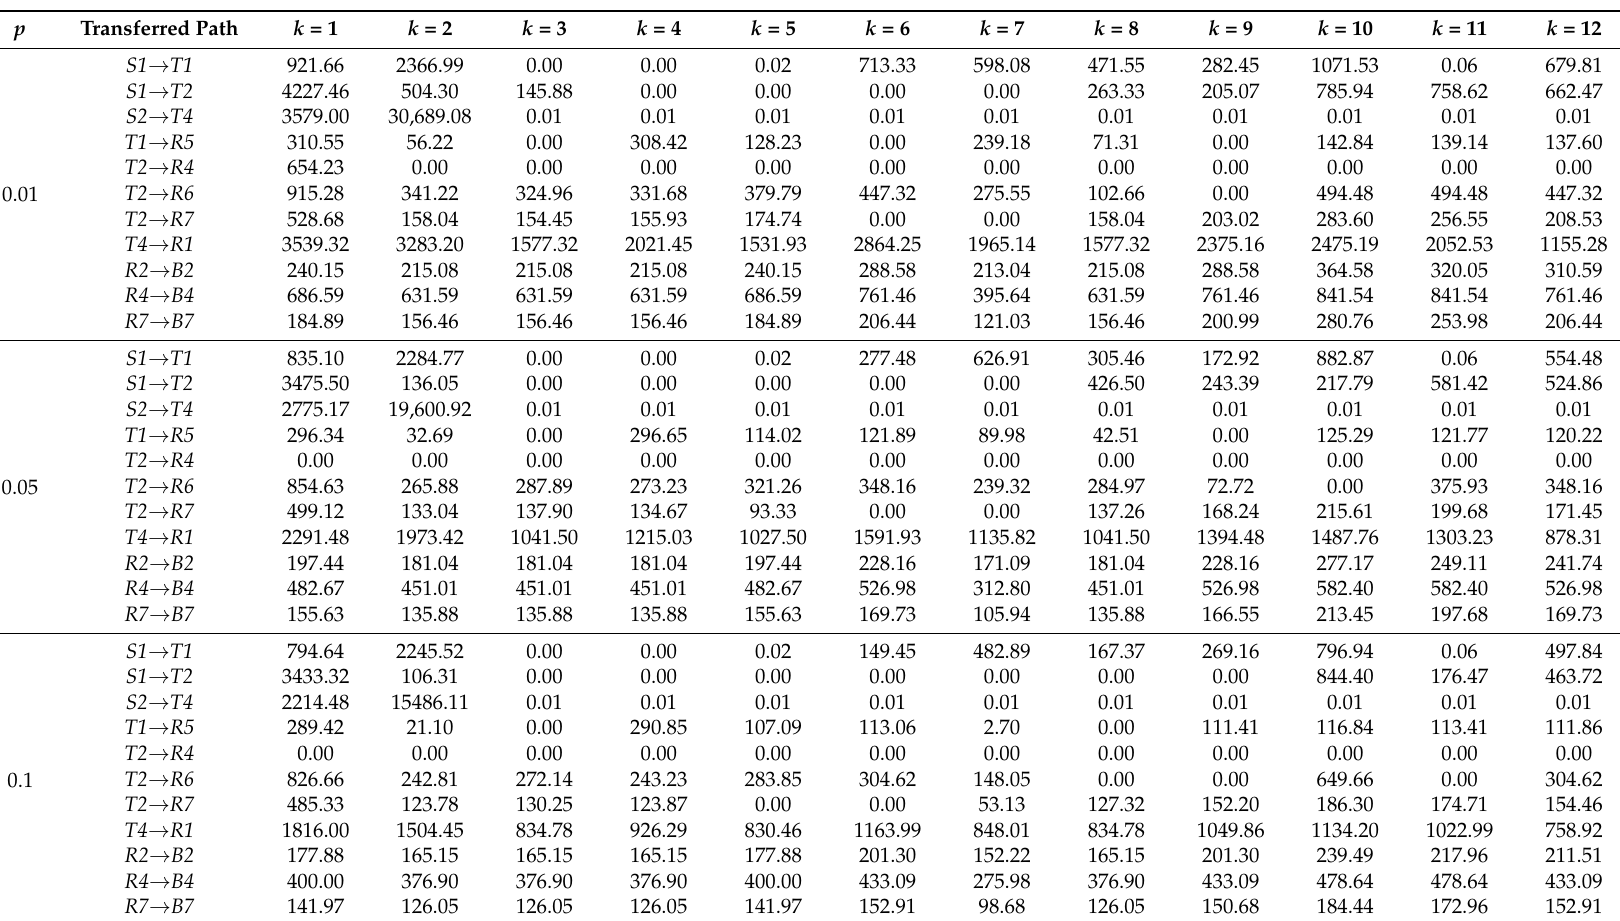
Table 5. Part of the solutions from the SMOCCP model under three constraint-violation levels at w 1 = 0.1 and w 2 = 0.9 ( × 10 3 m 3